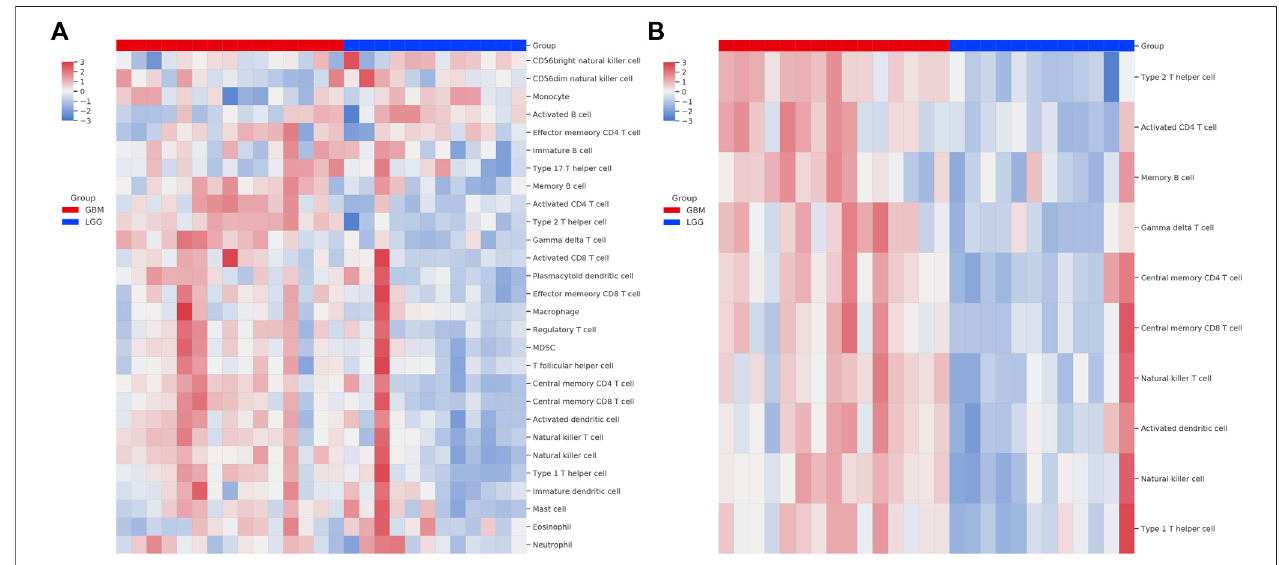
FIGURE3| Single-sampleGSEA(ssGSEA)analysisofimmune cellin fi ltrationintumor. (A) Heatmap of28immunerelated celltypesinpatients; (B) heatmapofthe types of immune cells passed the signi fi cant level in Student ’ s t